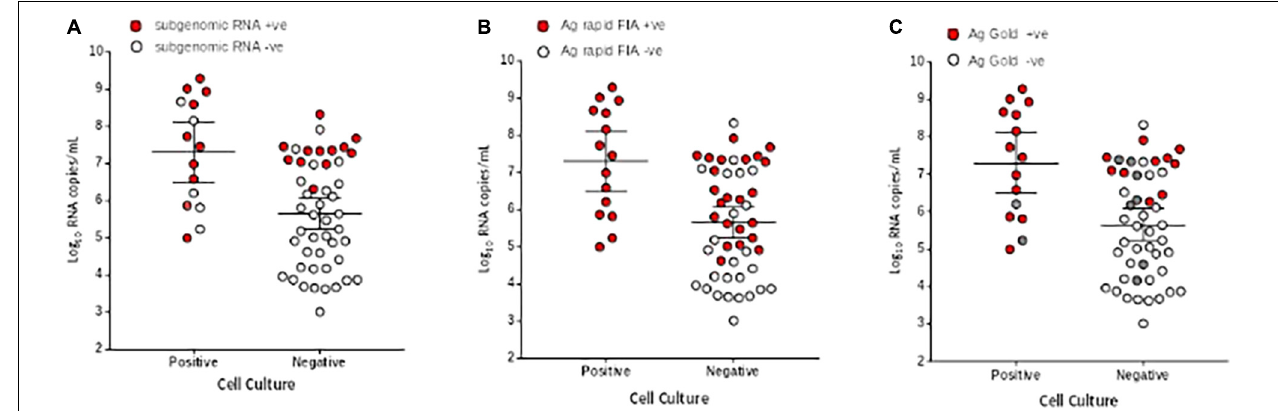
FIGURE 4 | Comparison of viral RNA loads (Log 10 RNA copies/mL) in respiratory samples of culture positive and negative samples. (A) Subgenomic RNA, (B) Ag rapid FIA, and (C) Ag Gold. The respiratory specimens are plotted by log 10 RNA copies/mL (y-axis) and are stratified by SARS-CoV-2 cell culture results (positive, n =15, negative, n =48). Subgenomic RNA, Ag rapid FIA, and Ag Gold positive results are indicated as red data points ( n =25, 38, and 23, respectively), whereas negative ( n = 41,22, and 31 respectively) as white data points. In case of Ag Gold, the unavailability of samples is indicated as grey data points. The horizontal lines on x-axis indicate mean and 95% confidence interval.